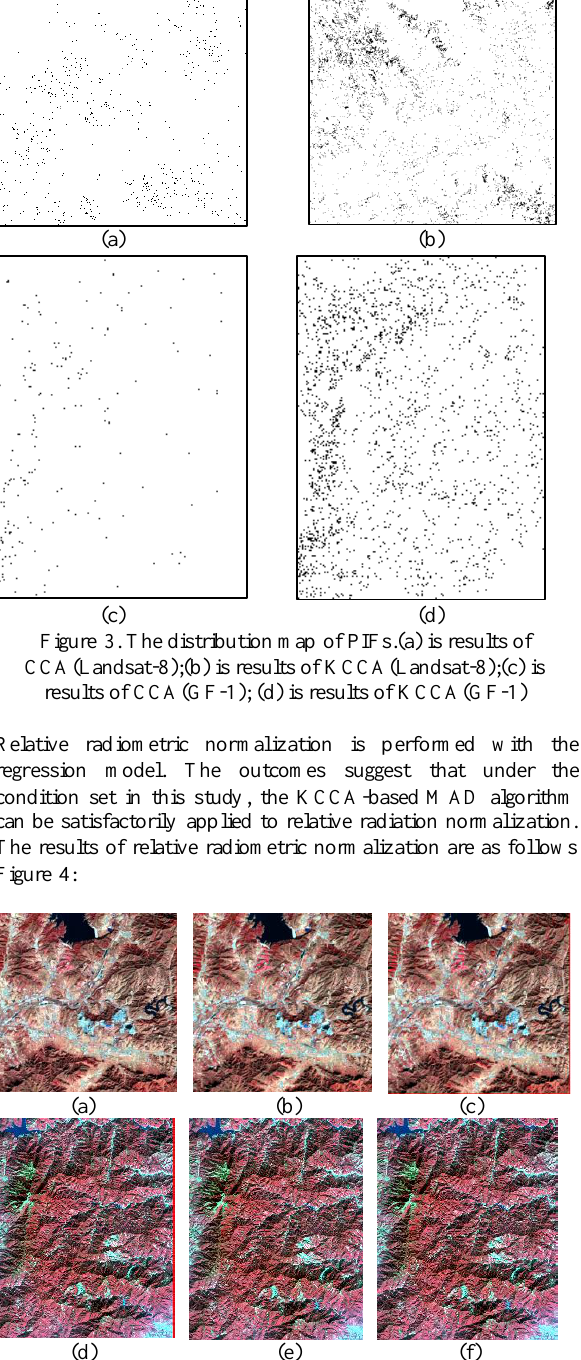
Figure 4. Relative radiometric correction results